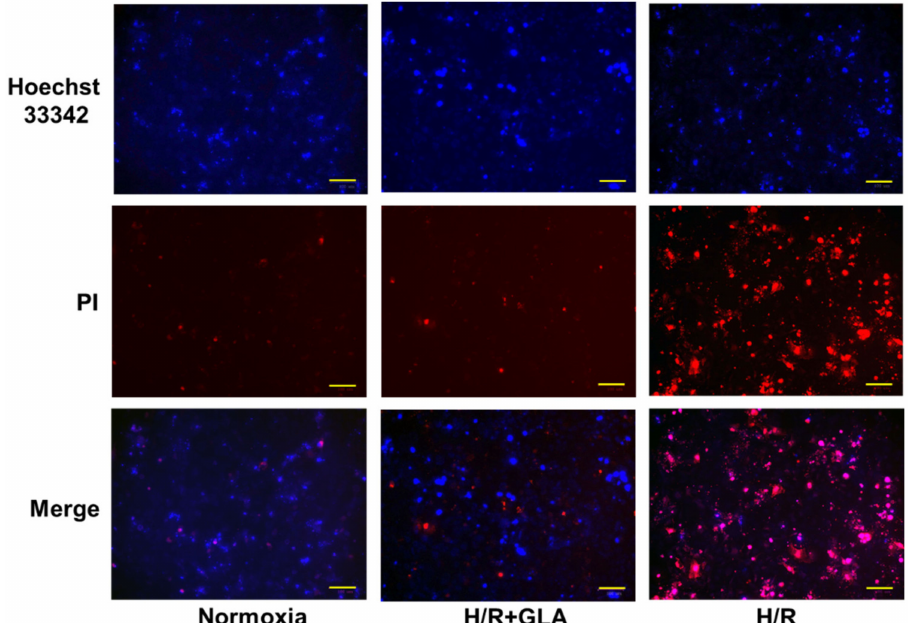
Figure 4. Effects of GLA on H/R-induced cell death in HK-2 cells. The cells were pre-treated with 5 µ M GLA for 2 h and then exposed to H/R for 24 h. Cells stained with Hoechst 33342 (blue) and propidium iodide (PI, red) dyes were observed and photographed with a fluorescence microscope. Scale bars = 100 µ